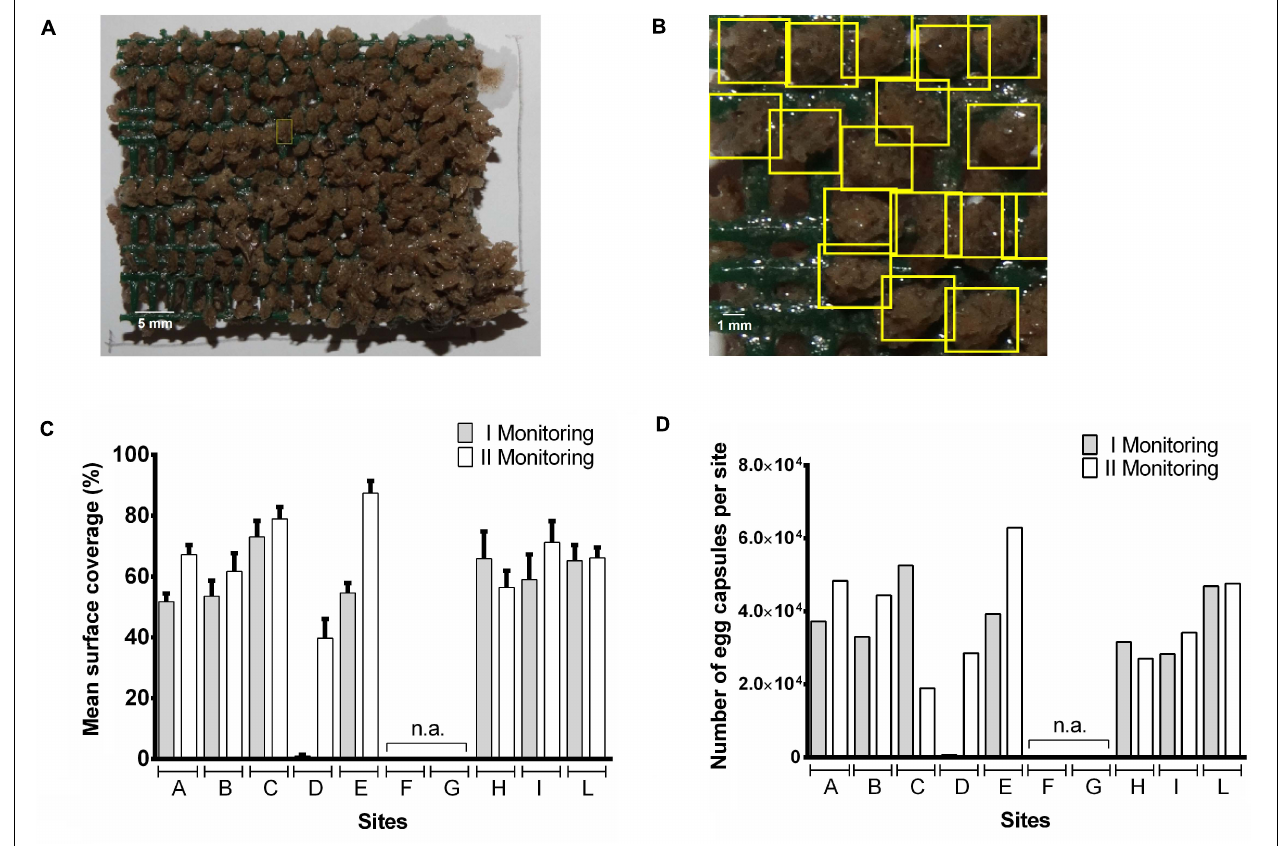
FIGURE 2 | Automatic counting of Tritia mutabilis egg capsules deposited on artificial substrates by Digital Image Processing techniques associated with machine learning methods. Color images of T. mutabilis egg capsules deposited on the surface of each pyramid were processed using two distinct approaches: Homography-based Identification (HI; A) and Deep Learning Neural Networks Identification (DLNNI; B) . Results are shown as both mean percentage of covered surface per site (C) and total number of egg capsules per site (D) .